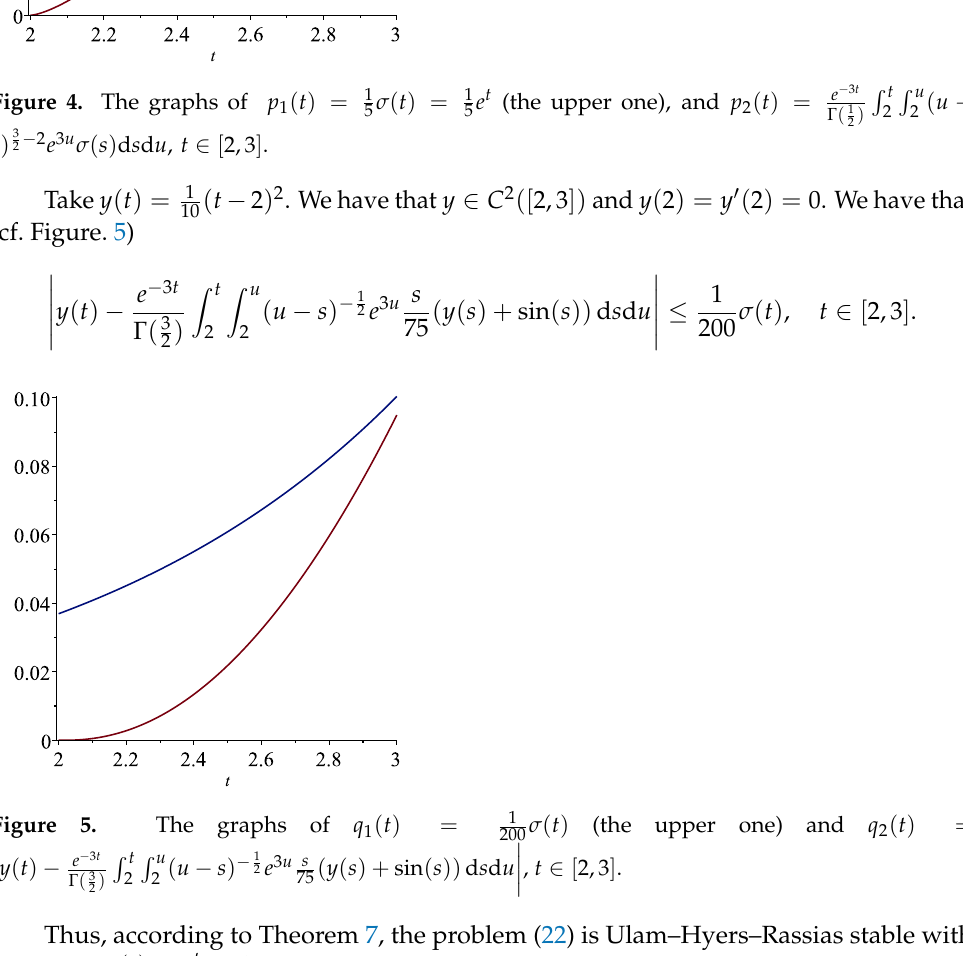
e t (the upper one), and p 2 ( t ) = e − 3 t σ ( t ) = 1 5 5